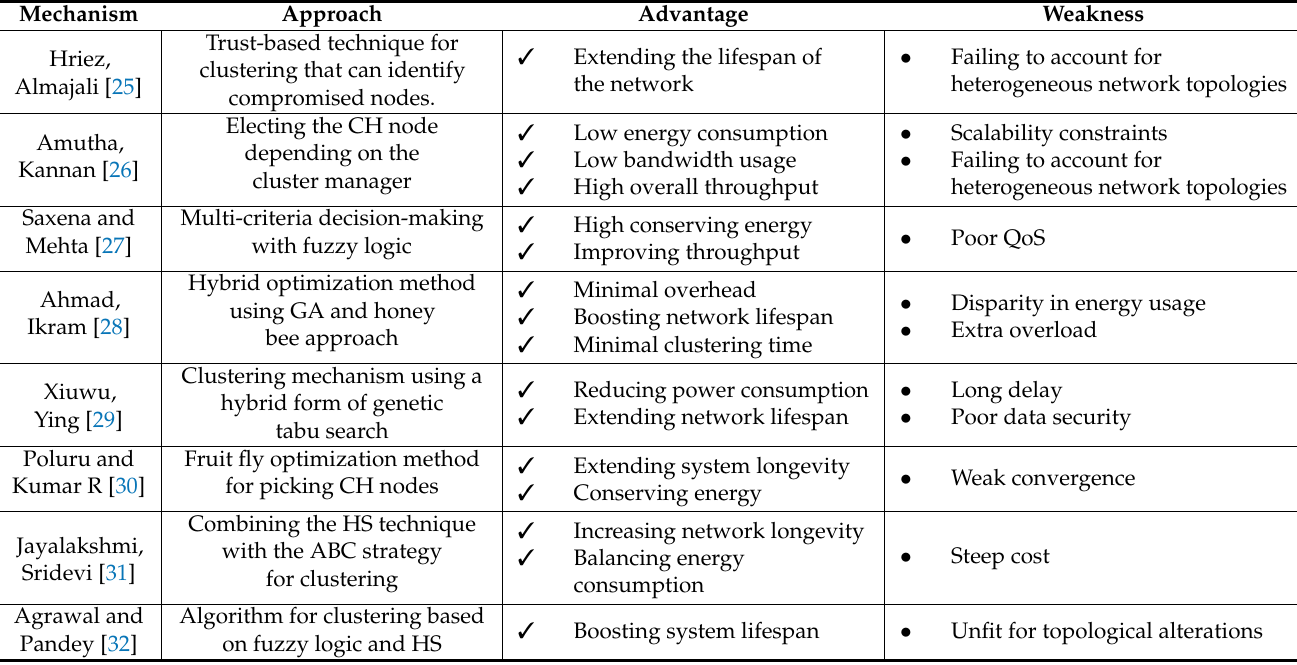
Table 1. Comparison of the different methods